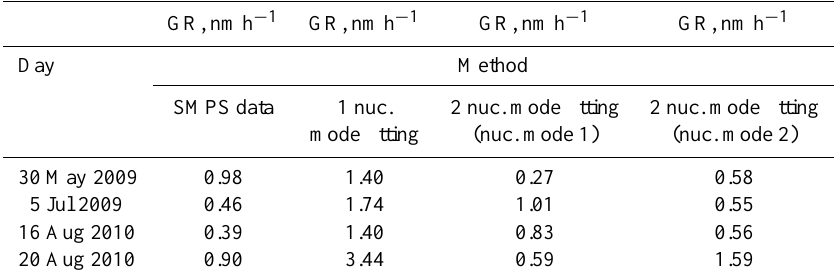
Table 5. Mean values of growth rates during four type Ia determined with three methods: (1) SMPS data, (2) fitting to 3 lognormal mode with 1 nucleation mode, and (3) fitting to 4 lognormal mode with 2 nucleation mode. GR, nmh −